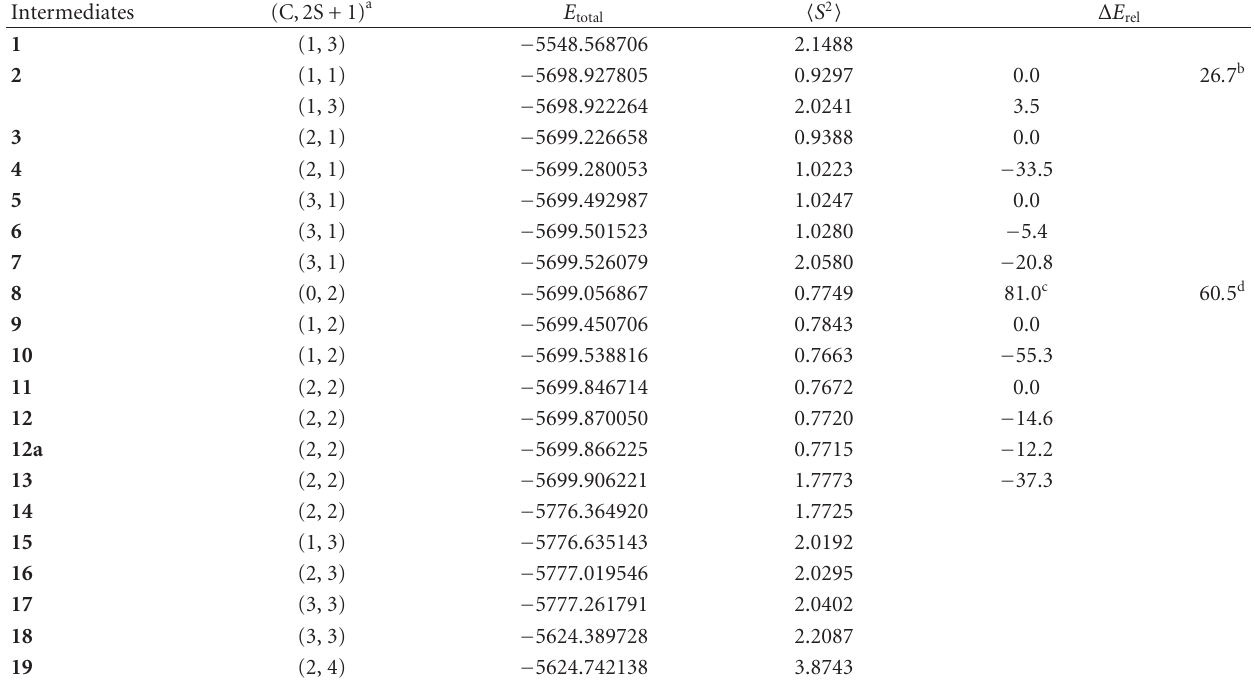
Table 2: Total energies (au), expectation values of square of spin angular momentums (au), and relative energies (kcal/mol) of optimized intermediates.